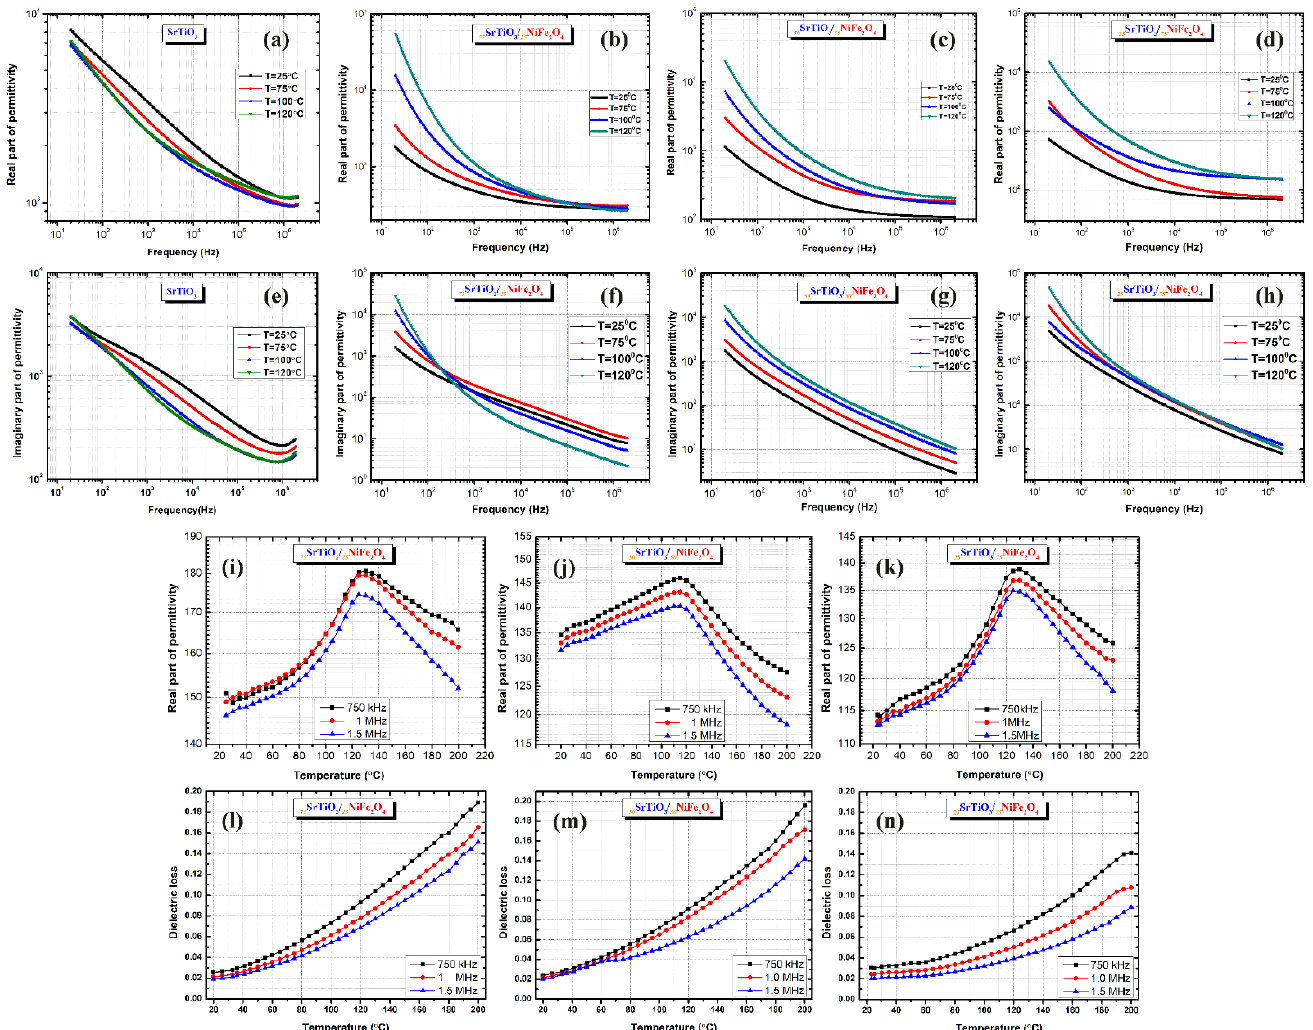
Figure 8. Dielectric dispersion at few temperatures of the materials: ( a , e ) real and imaginary parts of permittivity of the SrTiO 3 ; and ( b – d ) real part of permittivity and ( f – h ) imaginary part of permittivity of 100–x STO/ x NFO composites. Temperature dependence of the dielectric characteristics at a few selected frequencies for 100–x STO/ x NFO composites: ( i – k ) permittivity; ( l – n ) tangent loss.